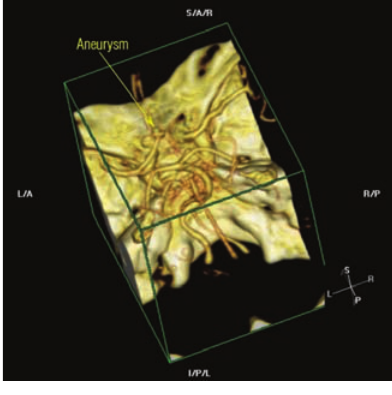
Figure 5. Computed tomography angiog- raphy showing a 5 x 3 mm midline aneurysm arising from the anterior com- municating artery.